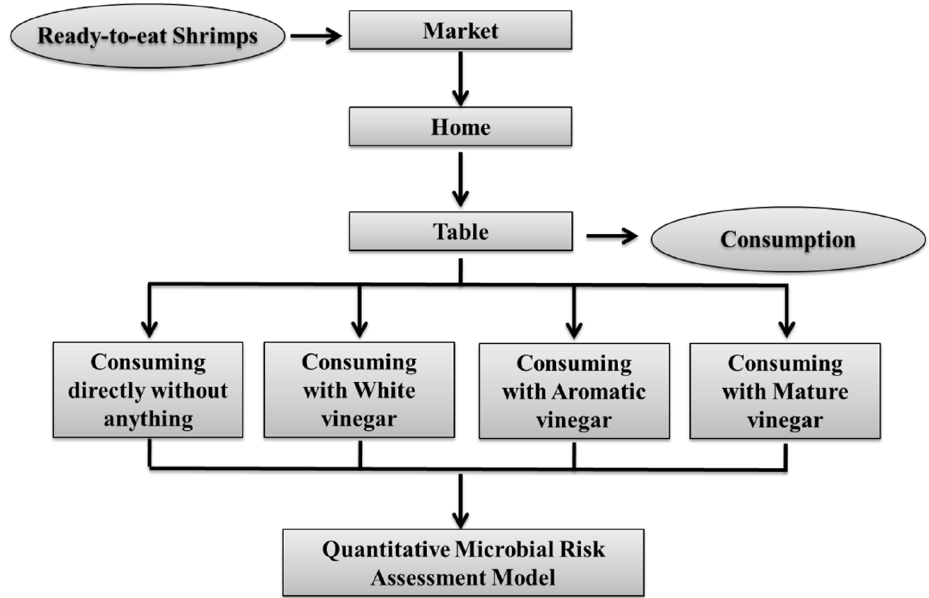
Figure 1. Diagram of the quantitative risk reduction assessment model for V. parahaemolyticus on ready-to-eat shrimp. The figure shows stages and their inputs from market to table. The input parameters of each stage are described in Table 2.